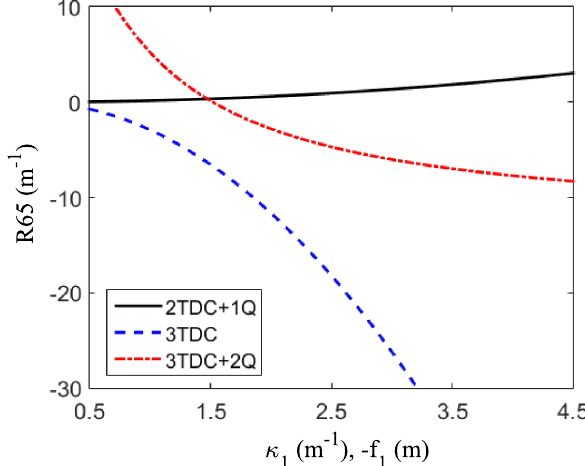
FIG. 5. Change in chirp ( R 65 ) as a function of cavity kick strength ( κ 1 ) for a 2 TDC þ 1 Q and a 3TDC configuration and focal length of the first quadrupole ( f 1 ) for a 3 TDC þ 2 Q configuration.